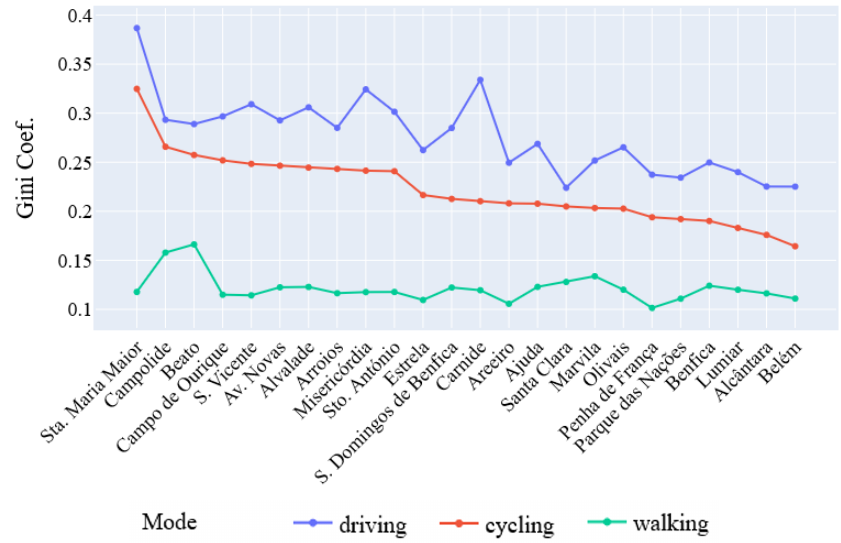
Figure 12. Gini coefficient for Lisbon’s parishes in 2020.